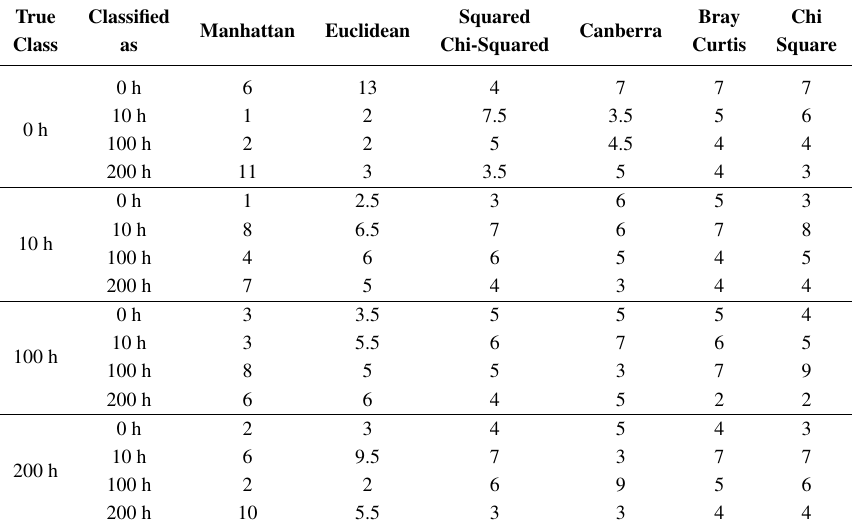
Table 10. Confusion matrix of the classification means for the 5-MHz frequency backscattered signals at 950 ◦ C.